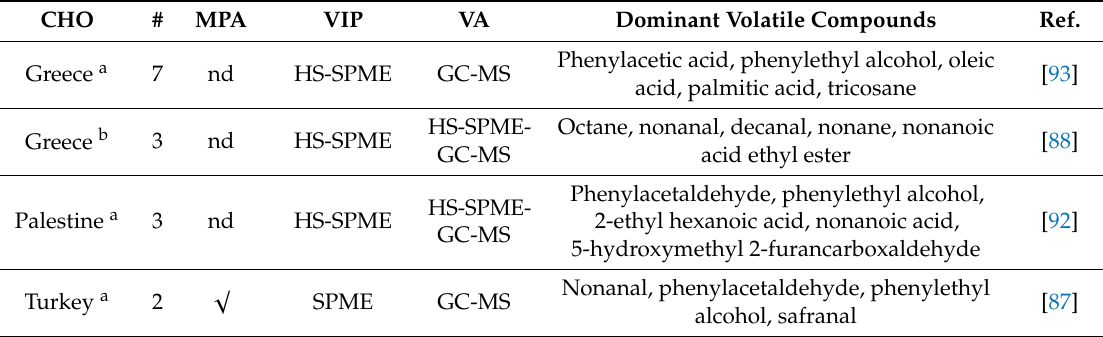
Table 6. Cotton honey’s main volatiles, with reference to the country of origin, number of samples, isolation and analysis procedures and five main volatile components. Unless otherwise specified, the honeybee type was A. mellifera .